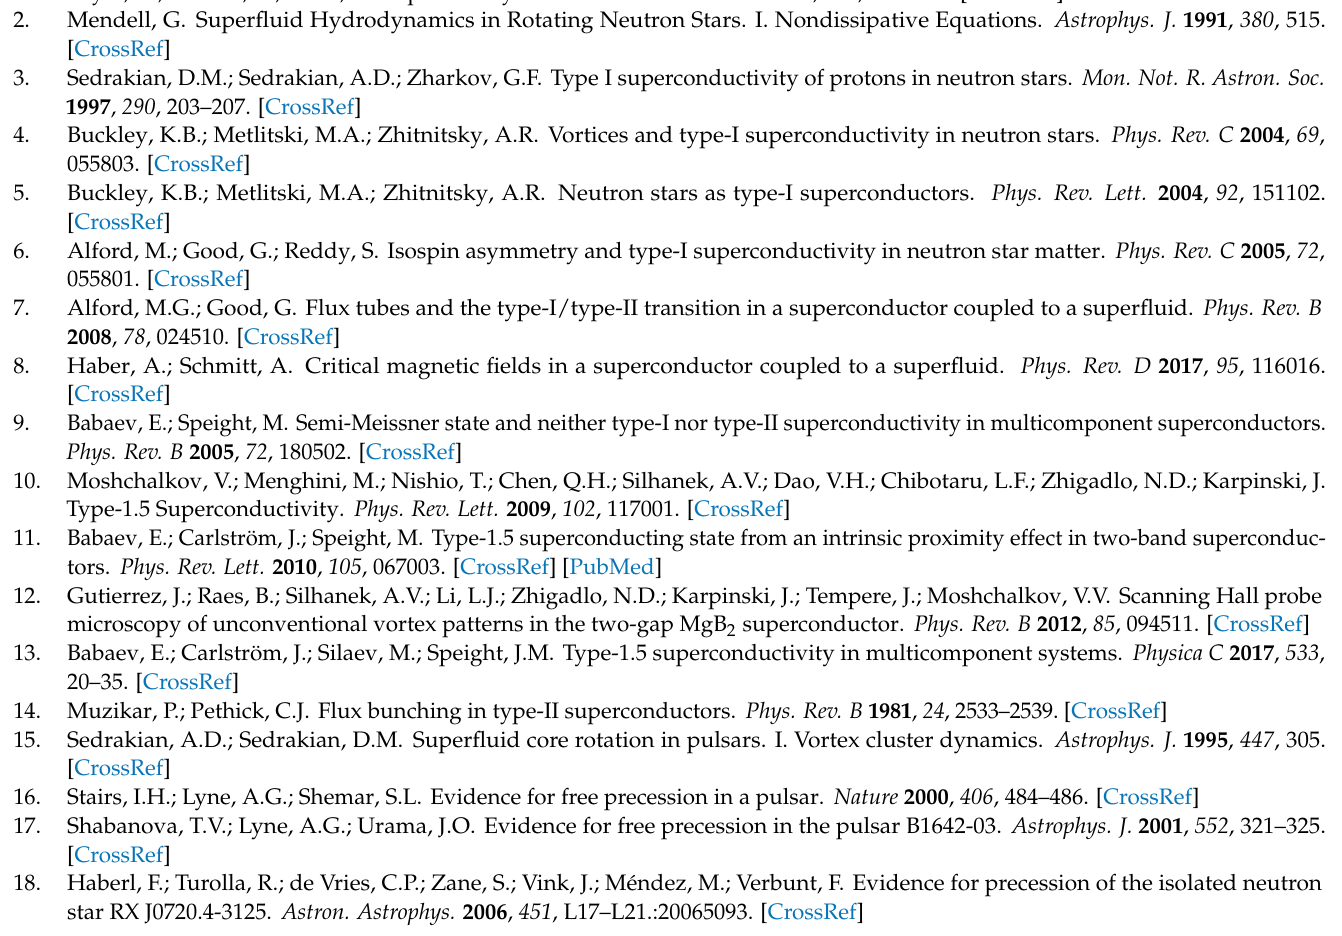
Figure A1. The Helmholtz free energy per flux quantum per unit length, states, with (dimensionless) parameters h 1 = 0.061, h 2 = 0.422, h 3 = 0.062, R = 0.412, (cid:101) = 0.096, and κ = 1.17. The true ground state (dotted, gray line) arises as a subcritical bifurcation from the non-superconducting state (short-dashed, purple line). The two insets show more detail of the cross-over regions between two lattice configurations of different